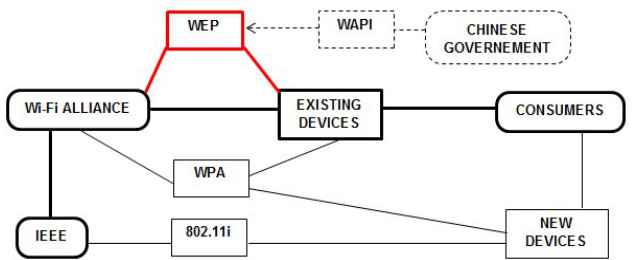
Fig. 6. Wi-Fi Alliance mobilizing new allies, WPA and 802.11i, as a way to strengthen the network weakened by WEP, counter-attacking the threat posed by WAPI.